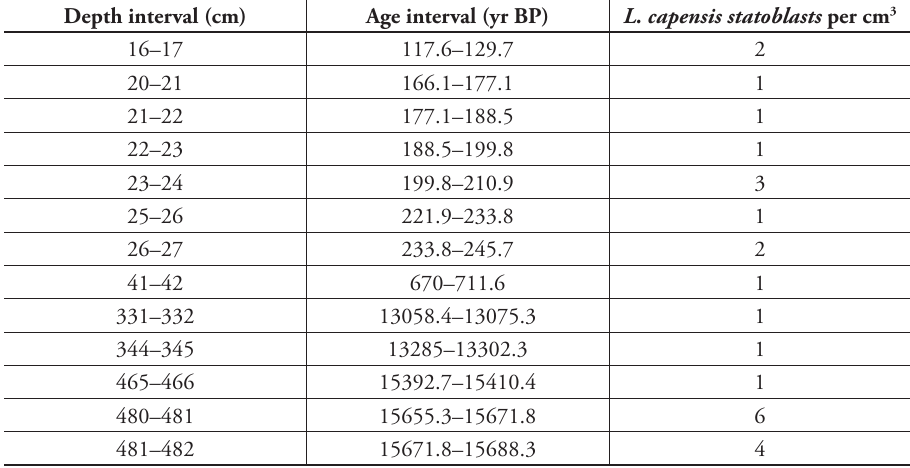
Table 3. Depth intervals and modeled ages of presence of L. capensis remains presented as concentrations of statoblasts per volume of wet